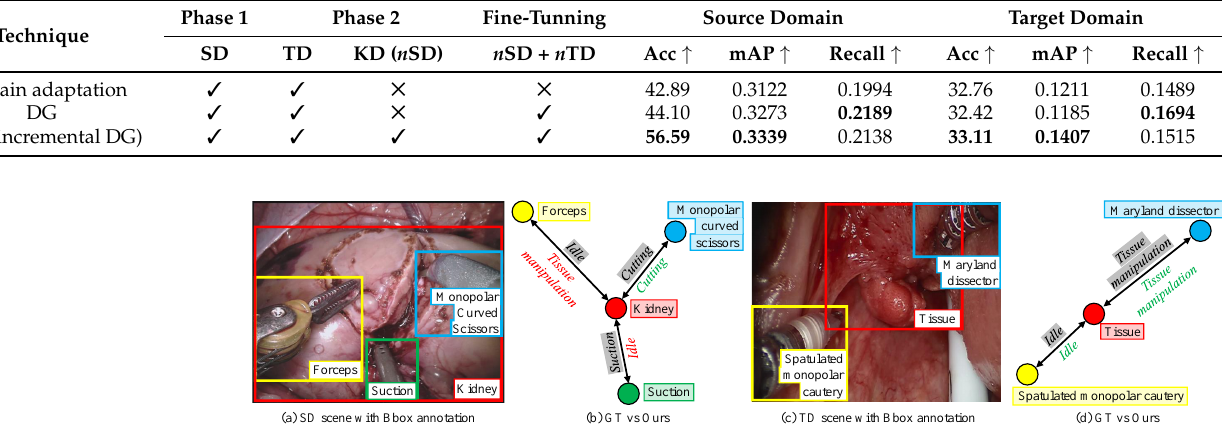
Figure 2. Qualitative analysis: ( a ) Source domain surgical scene with annotated bounding box (Bbox). ( b ) Ground truth (GT) interaction vs. our model’s prediction (in red and green text). ( c ) Target domain surgical scene with annotated Bbox and ( d ) GT interaction vs. our model’s